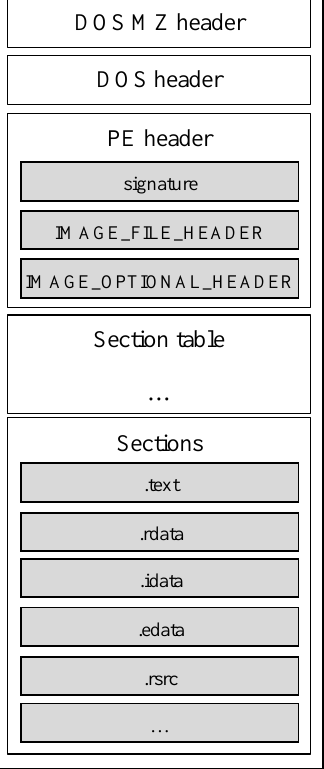
Fig. 3. The example of an infection by an inserting virus.